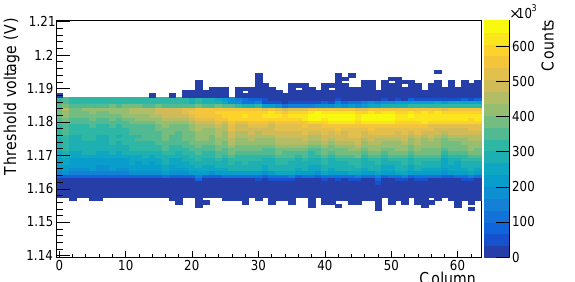
Figure 16. Test of the DECAL mask register. Test is a threshold scan with variable numbers of strips of pixels masked. Reading top to bottom, left to right, the number of unmasked strips is 1, 6, 16, 32, 64.